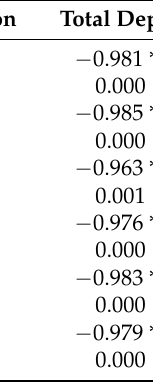
Table 2. Correlations between tourist service POIs and spatial variables.